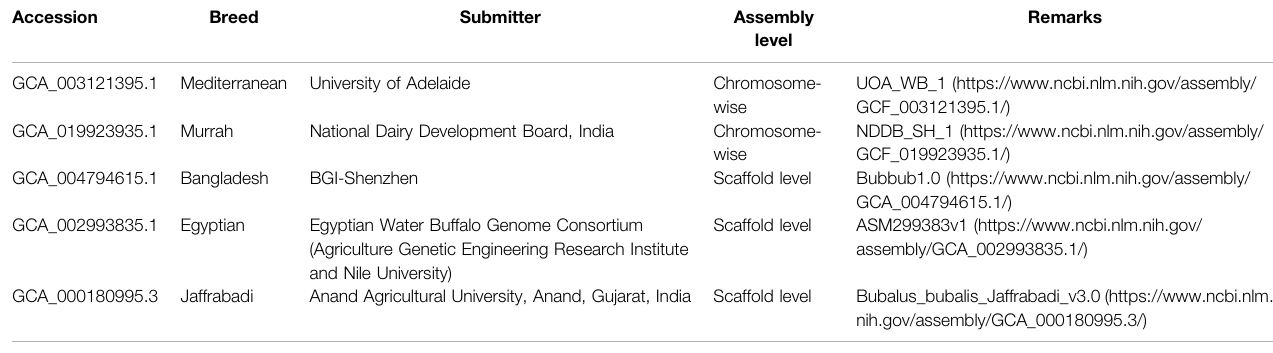
TABLE 1 | The list of assemblies of buffalo from public domain.